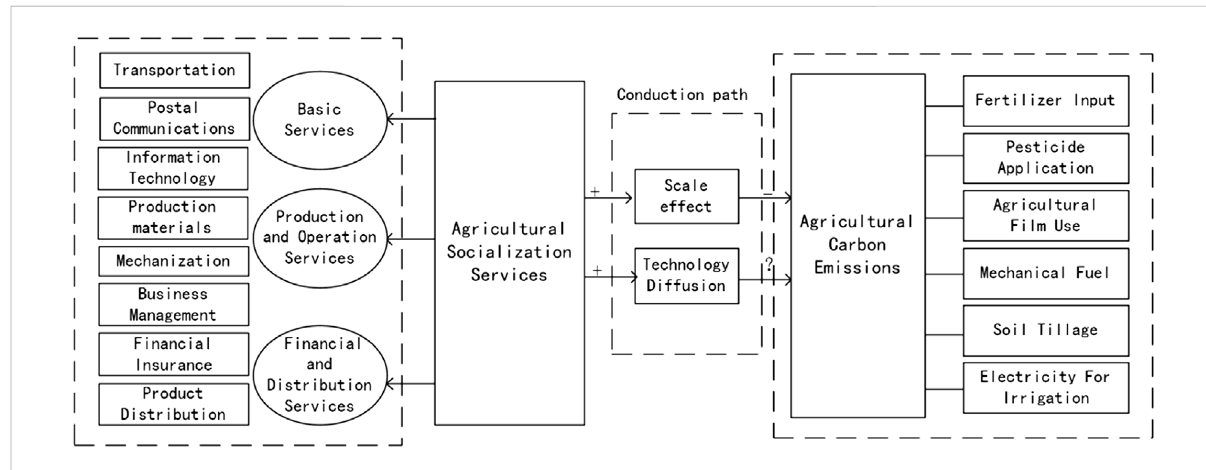
FIGURE 1 The transmission mechanism of the impact of socialized services on agricultural carbon